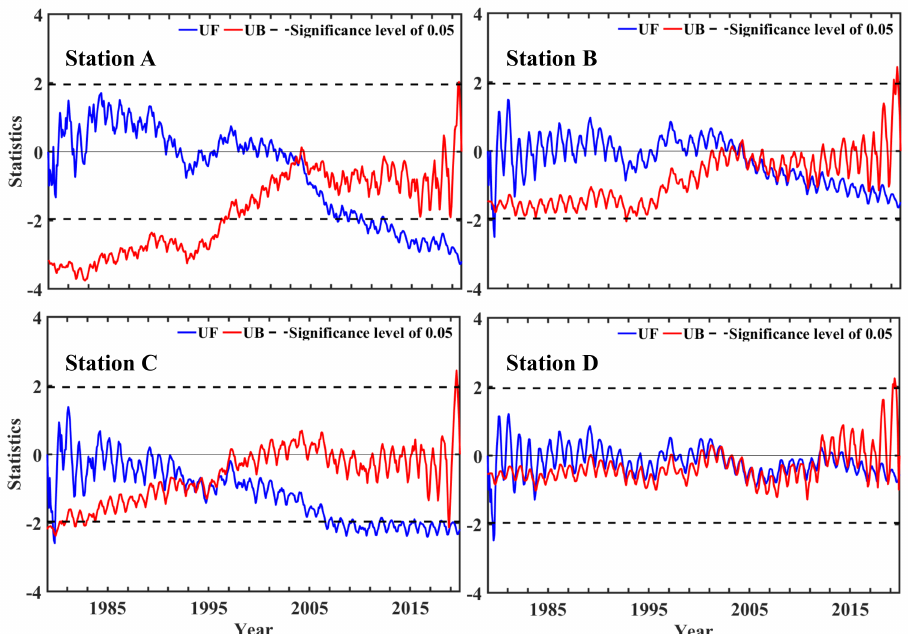
Figure 6. Mann–Kendall mutation analysis of monthly mean wind speed at station A, B, C and D, respectively, from 1979 to 2019. The UF and UB curves are shown in blue and red,